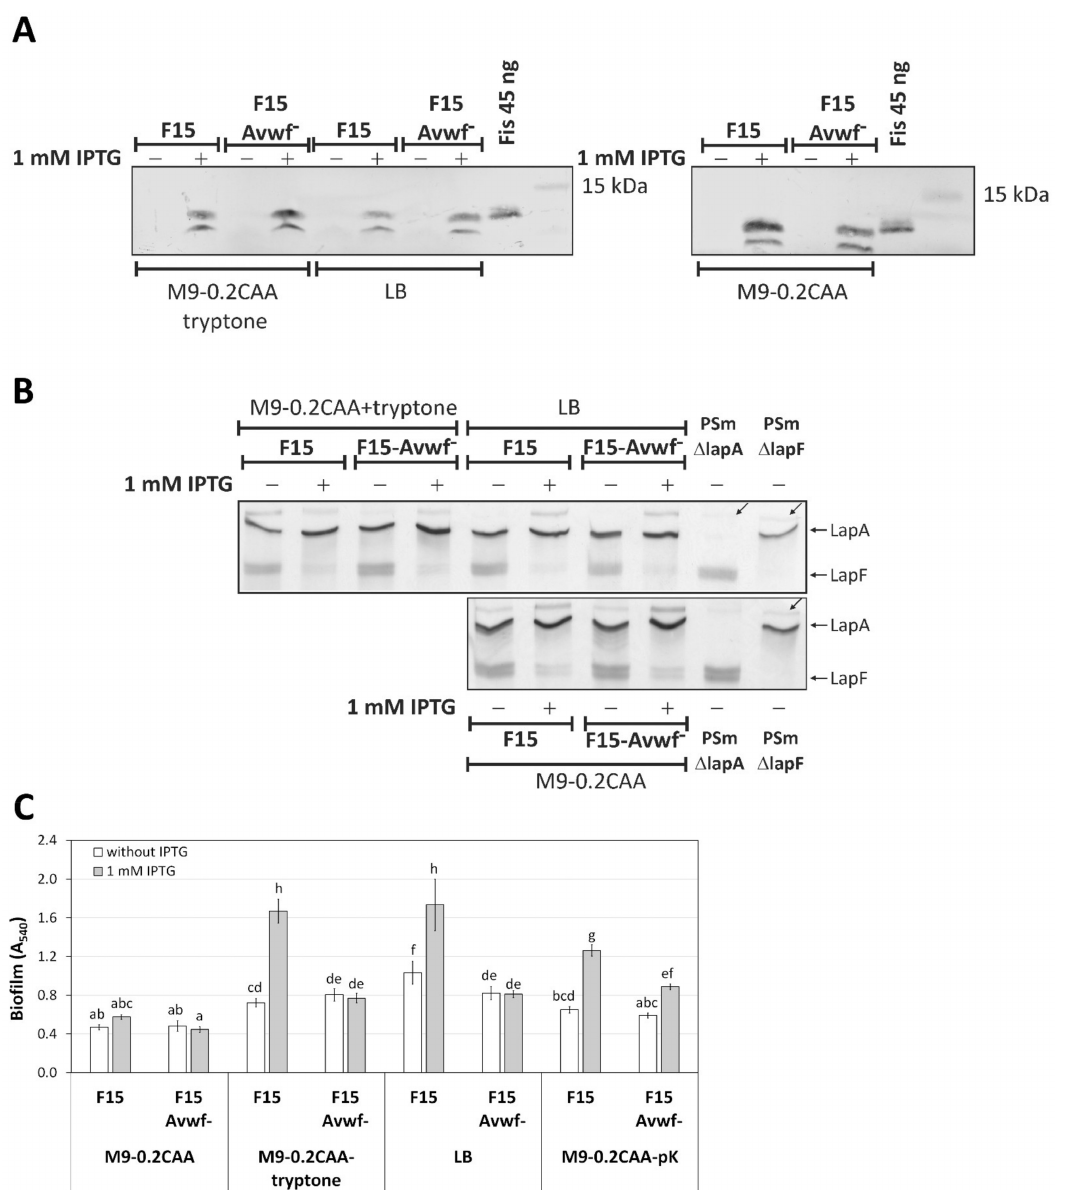
Figure 7. Expression of fis in F15-based strains by IPTG, the presence of LapA and LapF in cells and biofilm. ( A ) Expression of fis in P. putida F15 by immunoblotting using monoclonal anti-Fis antibodies. 10 µ g of total protein obtained from P. putida F15 grown in LB, M9-0.2CAA or M9-0.2CAA+tryptone media was loaded on a 12% SDS-PA gel. The supplementation of 1 mM IPTG is shown by “+” above the lane. 45 ng of purified Fis (6His) was used as a positive control. Protein marker band sizes are indicated. ( B ) SDS-PAA gel electrophoresis of crude cell lysates, 40 µ g of total protein is loaded to each lane. The media in which cells were grown for preparing crude cell lysates are shown to the left of the gel image. Cells were grown with and without 1 mM IPTG. The strains used in the analysis are shown above and below the figure. PSm ∆ lapA and PSm ∆ lapF strains were used as negative controls for LapA and LapF. LapA and LapF are indicated by arrows on the right side of the figure. Inclined arrows indicate an unknown protein complex. ( C ) Biofilm of P. putida F15-based strains. An arithmetical average of at least three biological parallels with 95% confidence intervals are given. Homogeneity groups are shown above the columns by lower-case letters. Identical letters denote nonsignificant differences ( p ≥ 0.05) between averages of biofilm. Multifactorial ANOVA was used for statistical analysis, analysed separately by